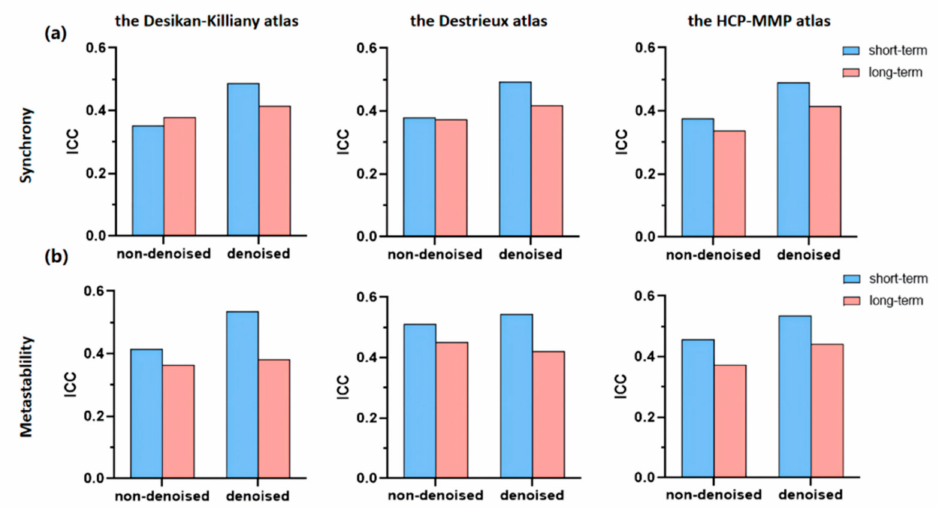
Figure 5. Reliabilities of synchrony ( a ) and metastability ( b ) in denoising strategies for the three brain atlases, evaluated by the intraclass correlation coefficient (ICC). Blue bars represent short-term reliability and pink bars represent long-term